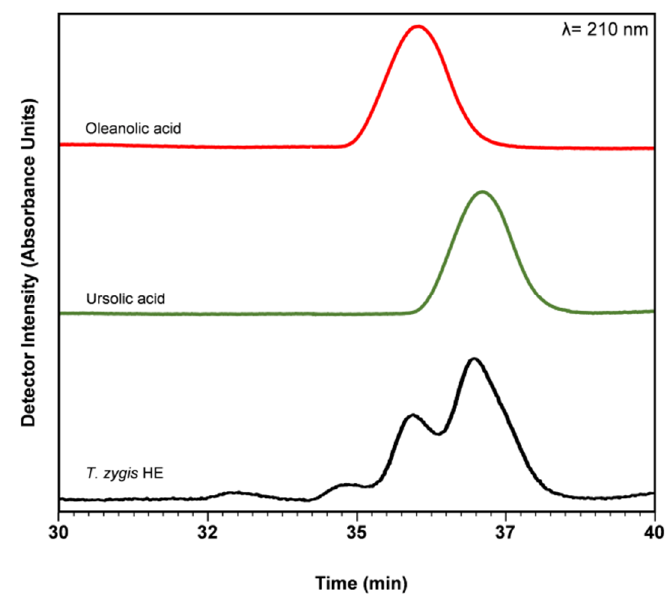
Figure 2. Chromatogram of oleanolic acid (OA) and ursolic acid (UA) standards and of Thymus zygis hydroethanolic (HE) extract.